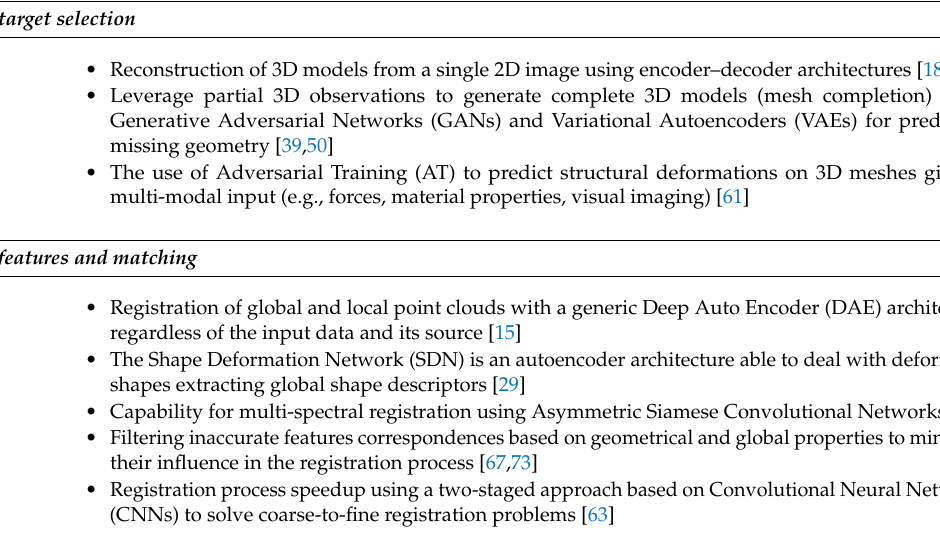
Table 2. Summary of the key advantages of the reviewed